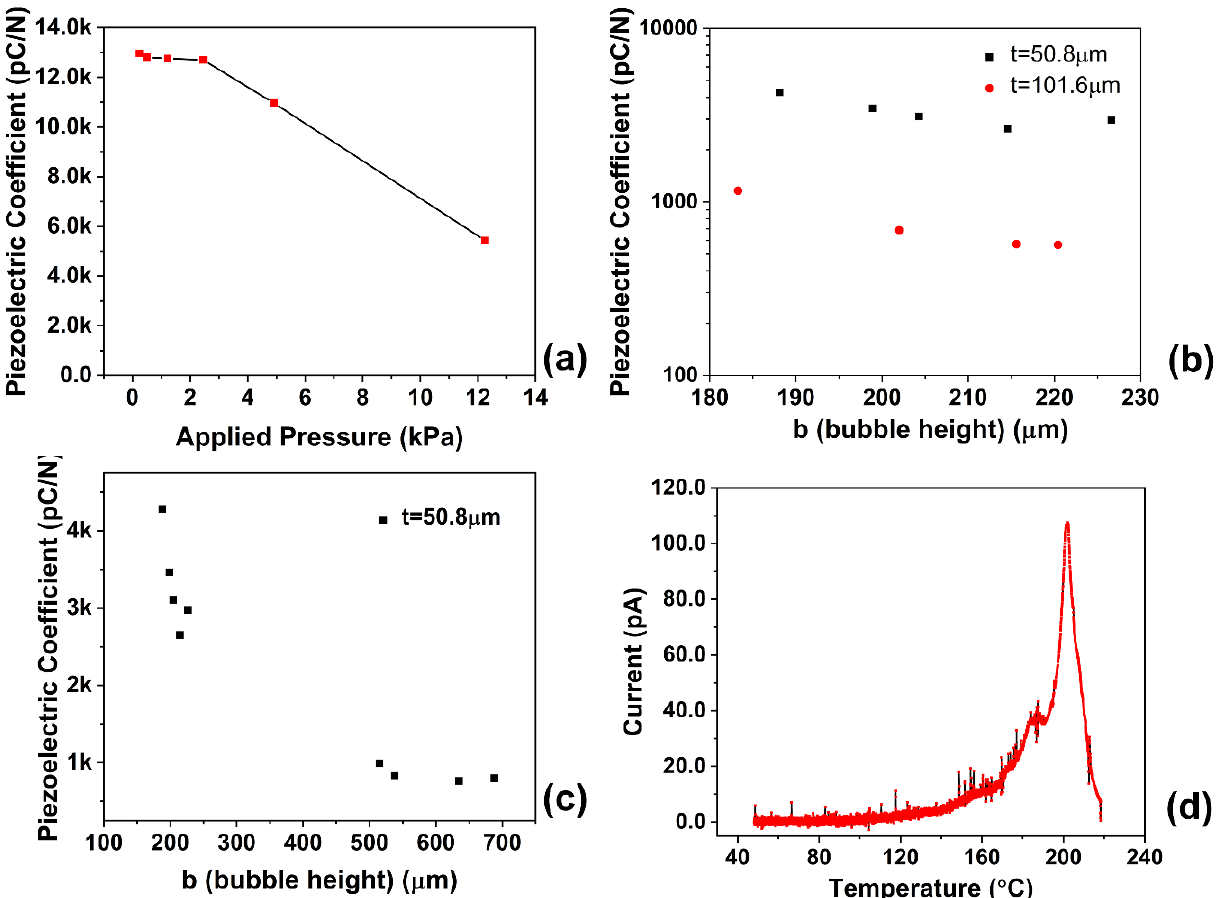
Figure 2. ( a ). Quasistatic piezoelectric coefficient of prepared piezoelectric foam (b = 240 µ m, t = 50.8 µ m); ( b ). Foam wall thickness’s effect on the sensitivity of the material; the d 33 value was under a pressure of 4.9 kPa; ( c ). Artificial void height’s effect on the sensitivity of the material; ( d ). Thermally stimulated discharge of prepared piezoelectric foam (b = 240 µ m, t = 50.8 µ m).